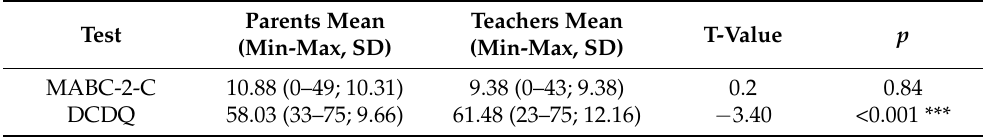
Table 3. Paired samples t -test of the MABC-2-C and the DCDQ between parents and teachers of children with suspected DCD ( n = 172).